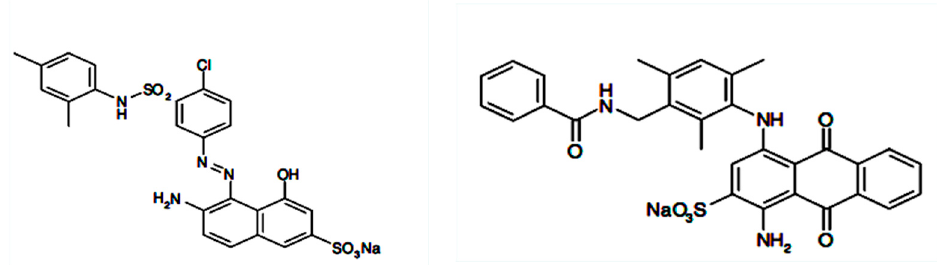
Figure 1. Chemical structures of the dyes.